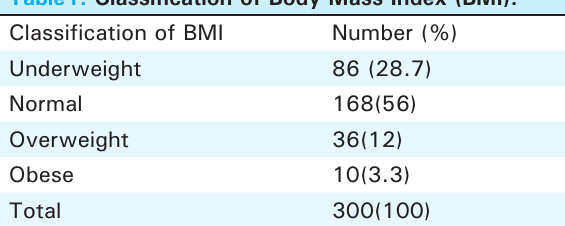
Table1. Classification of Body Mass Index (BMI).